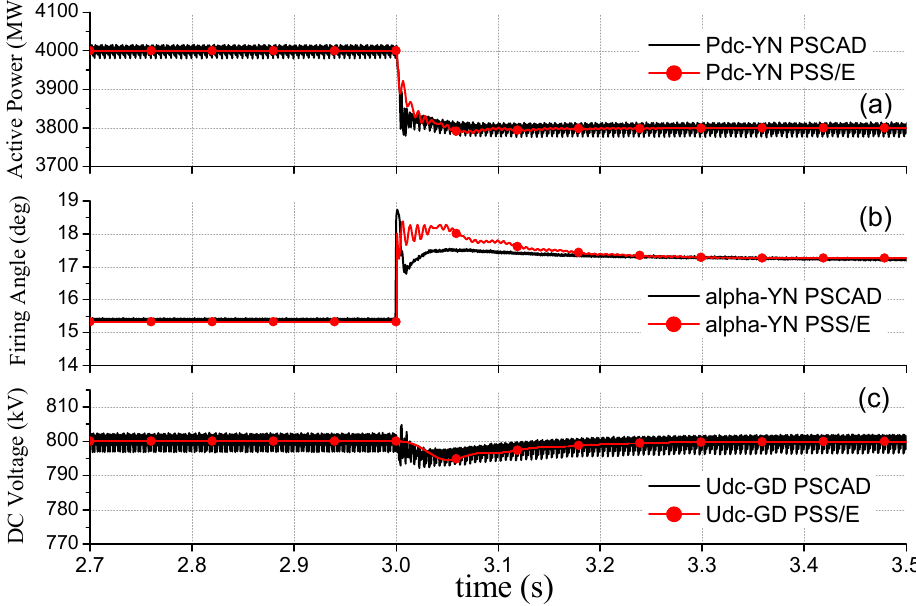
Figure 9. System responses of the electromechanical model compared with the electromagnetic model. ( a ) Active power of the LCC; ( b ) Firing angle of the LCC; ( c ) DC voltage of the GD MMC.